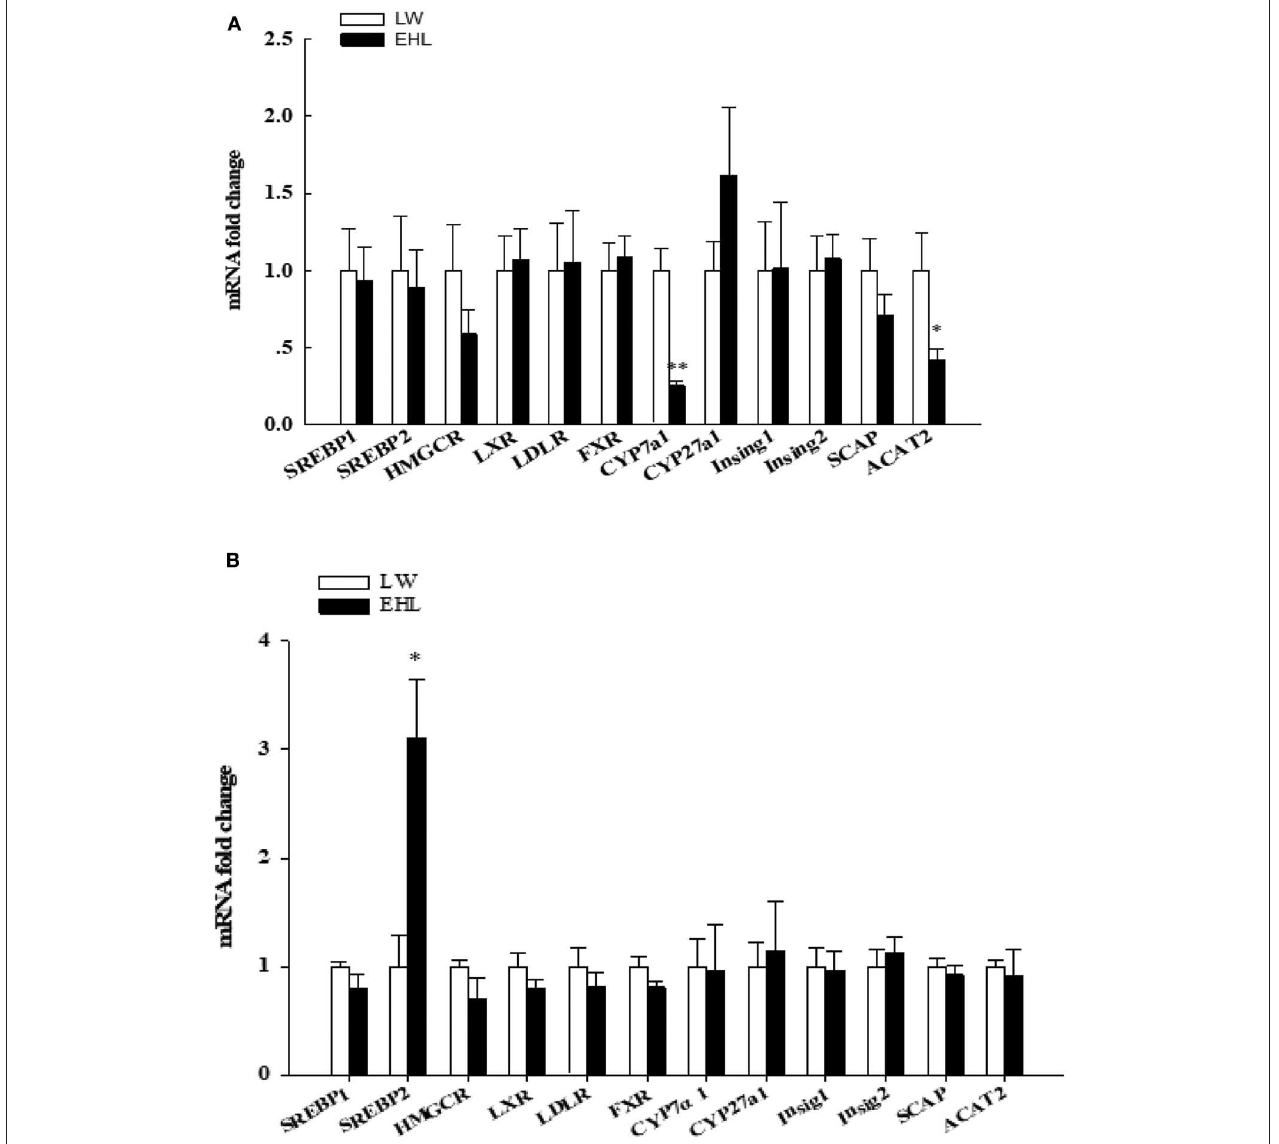
FIGURE 2 | Hepatic expression of genes involved in cholesterol metabolism of the offspring piglets at birth (A) and weaning (B) ( n = 6 piglets each time point per breed). * P < 0.05, ** P < 0.01. Data are presented as mean ± SEM.